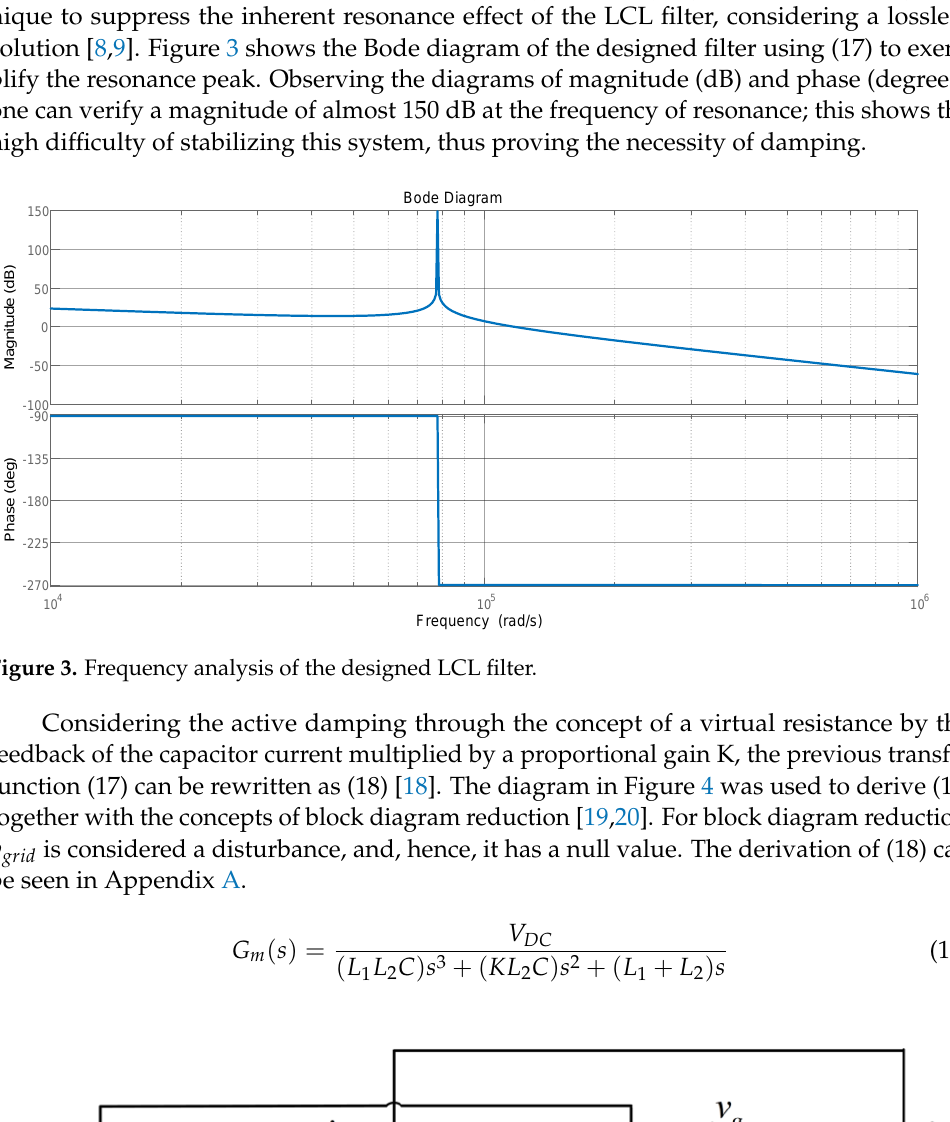
Figure 4. Block diagram of the active damping. 𝑉 𝑖𝑛𝑣 = 𝑚𝑉 𝐷𝐶 , 𝑖 𝐿1 = 𝑖 1 , 𝑖 𝐿2 = 𝑖 2 , and 𝑣 𝑔 = 𝑣 𝑔𝑟𝑖𝑑 .